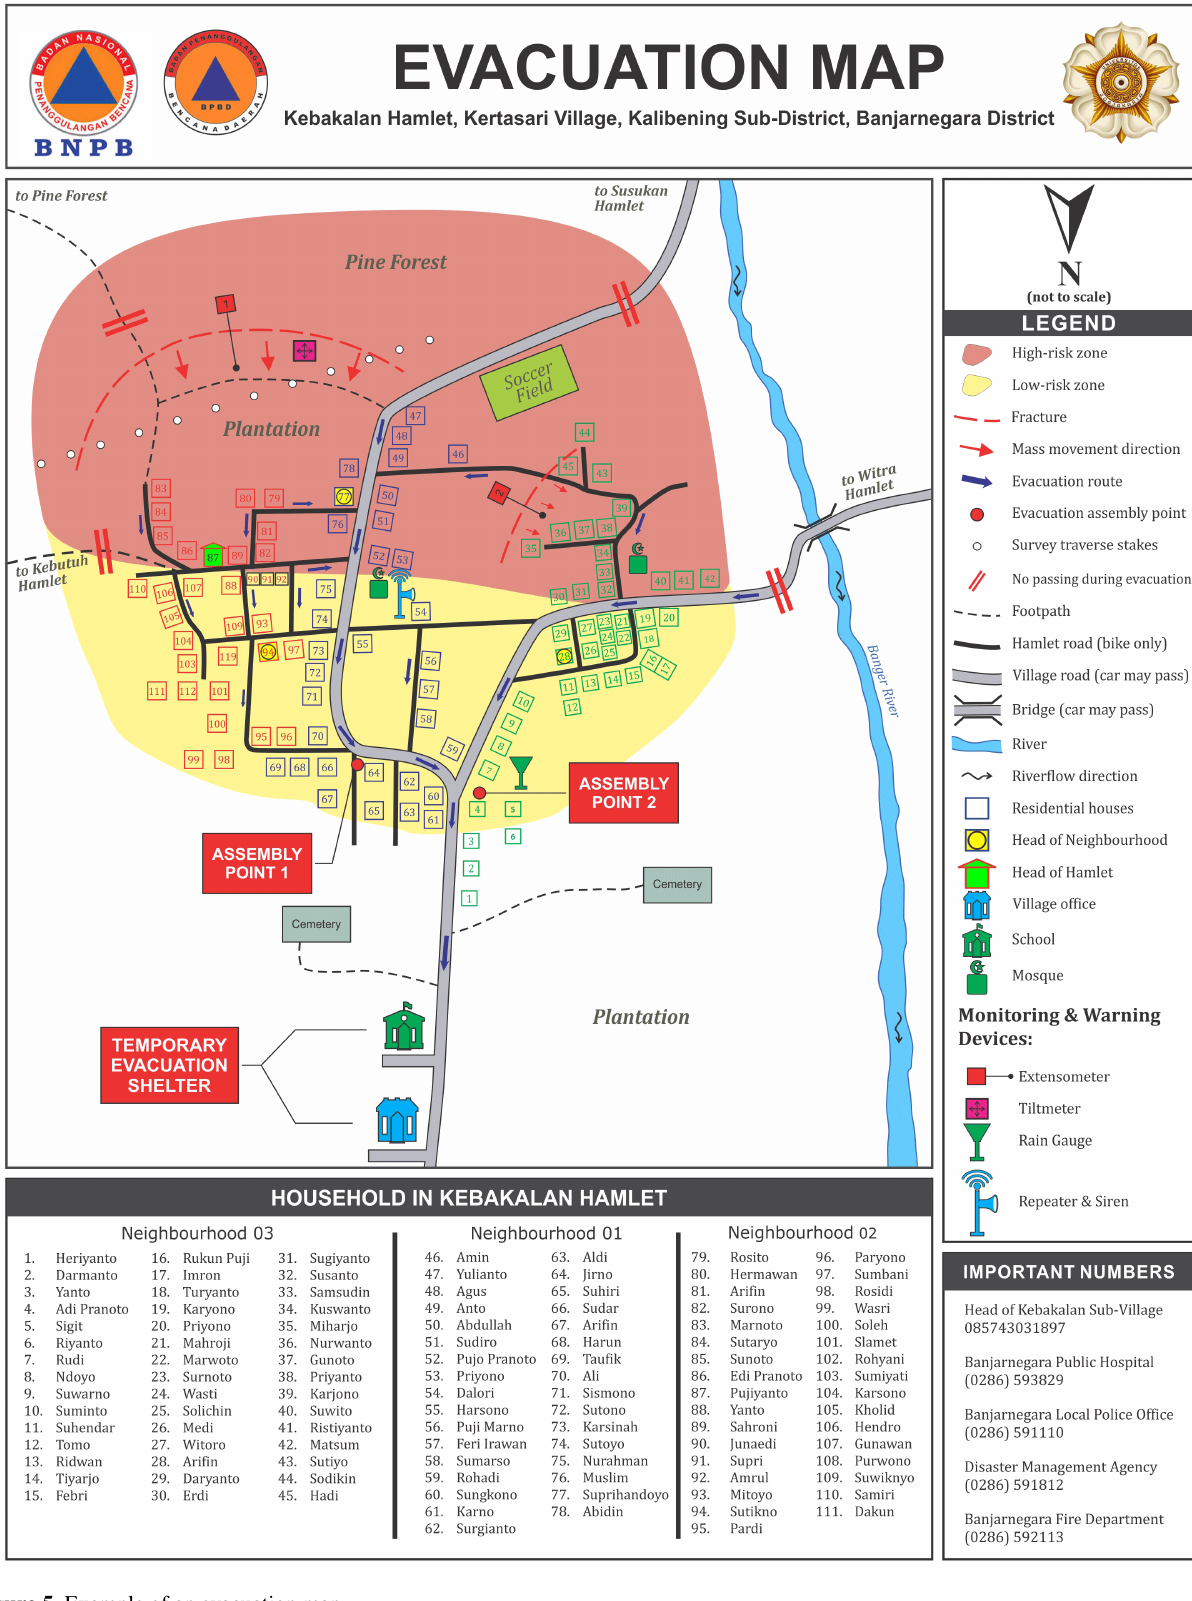
Figure 5. Example of an evacuation